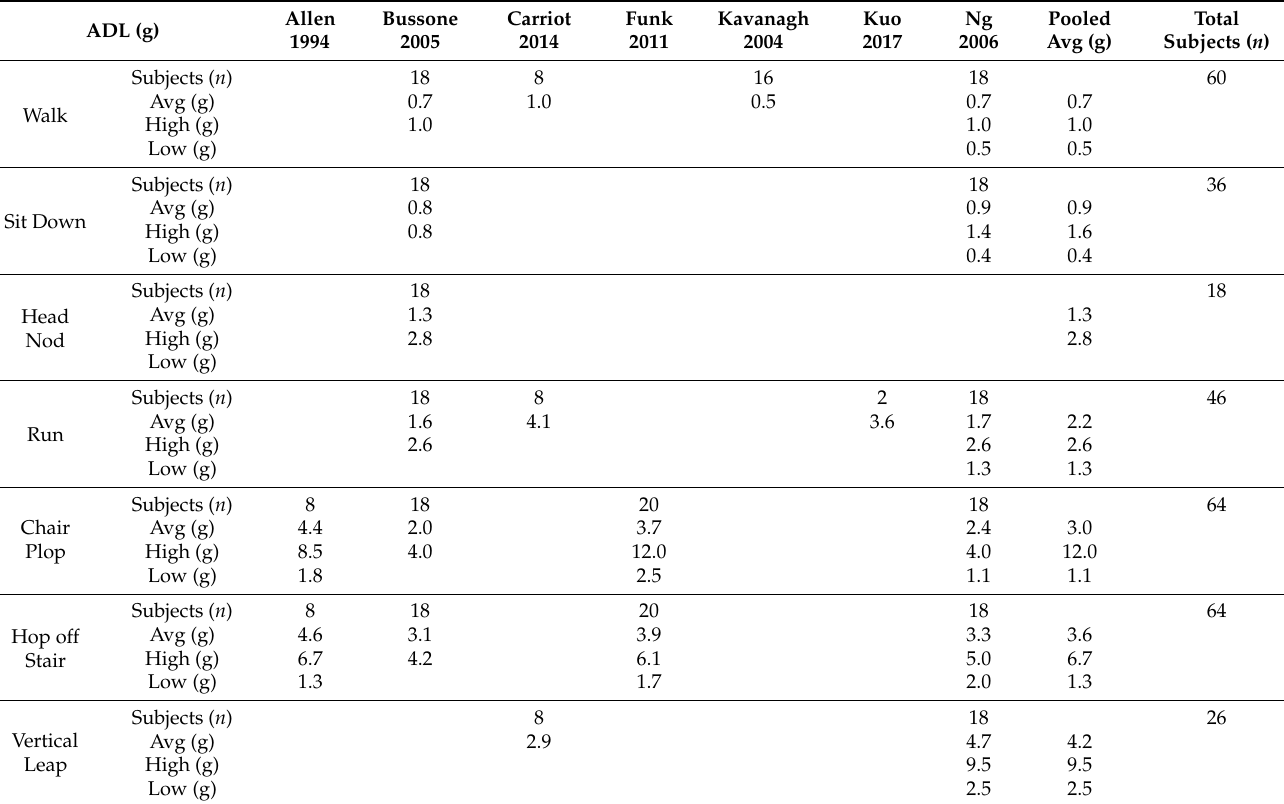
Table 2. Activities of daily living (ADL), highest head acceleration (g).